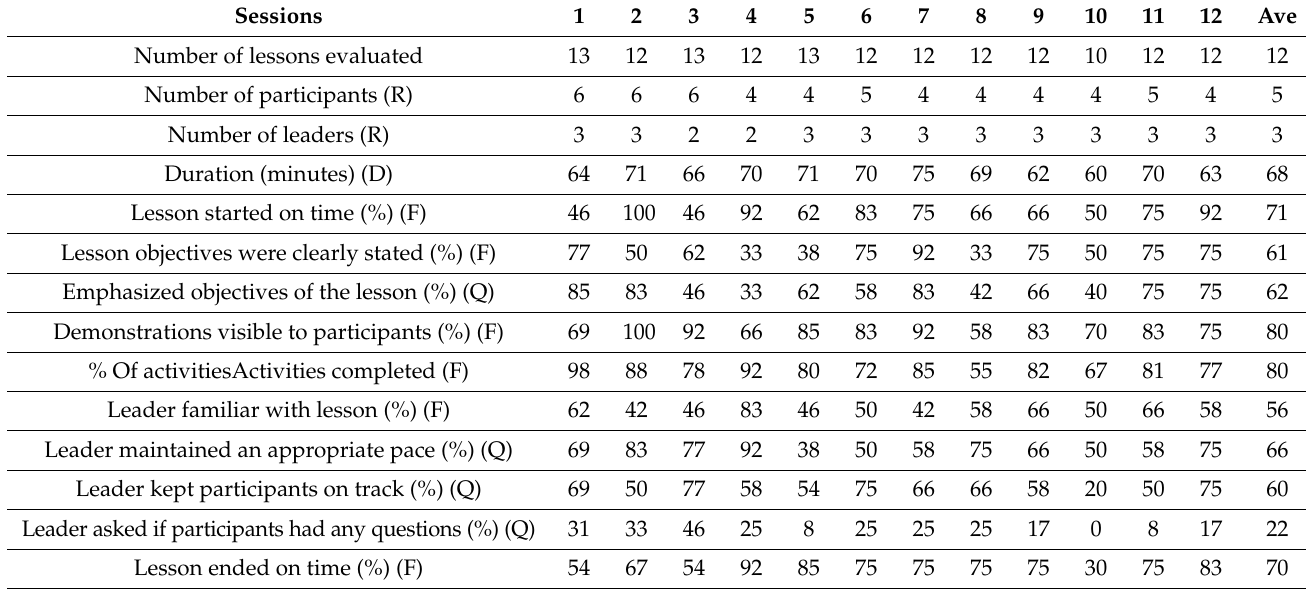
Table 1. Process evaluation (dose (D), reach (R), fidelity (F), quality (Q)). Results of peer-led sessions.